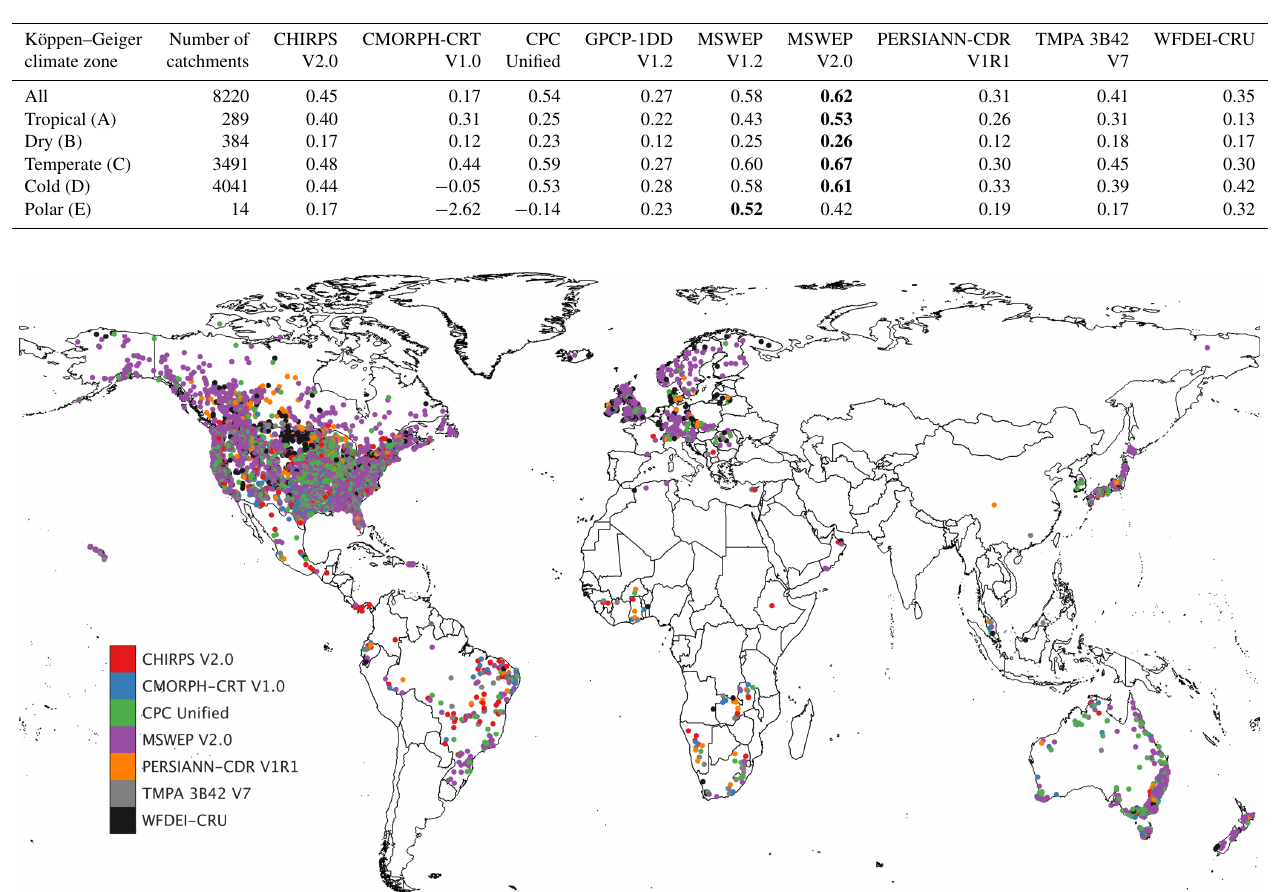
Table 3. Median calibration NSE scores for the gauge-corrected P datasets obtained using HBV. Only the catchments with calibration NSE values for all P datasets are considered. Thus, catchments at latitudes > 50 ◦ have been excluded. The results are grouped according to the five broadest Köppen–Geiger climate categories, commonly referred to using the letters A–E. Values in bold represent the highest score in each group.